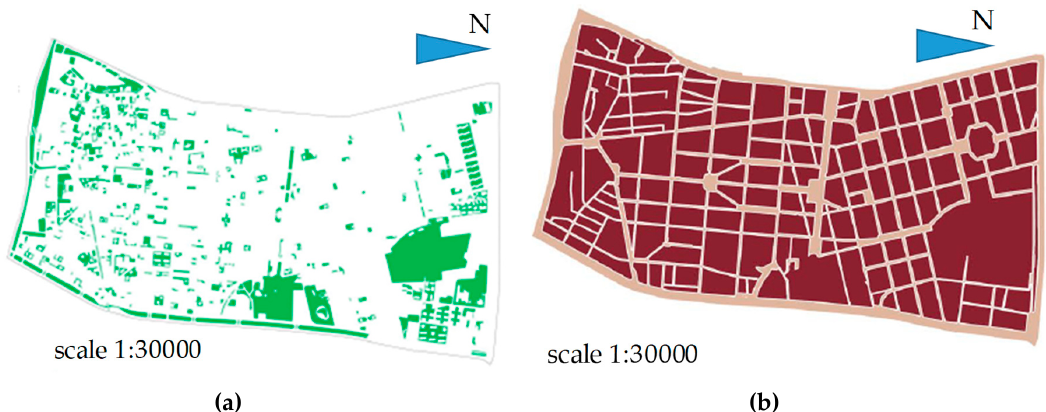
Figure 1. Map of a quarter in Rome: ( a ) permeable areas (green) and ( b ) road network (light brown).